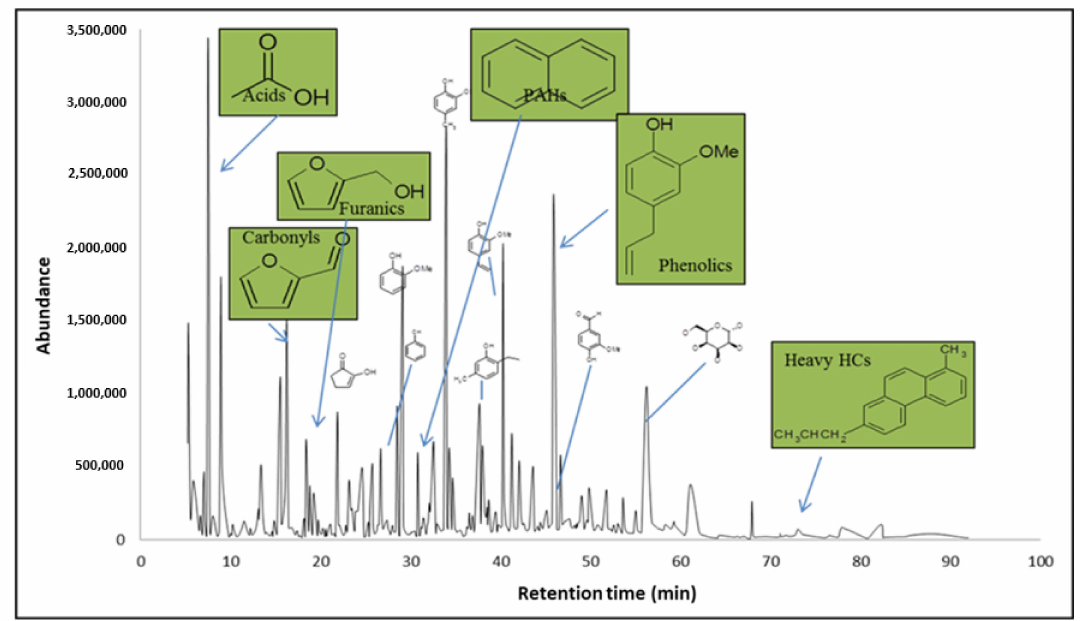
Figure 1. Ion-chromatogram of virgin bio-oil produced by thermal pyrolysis (without further treatment).